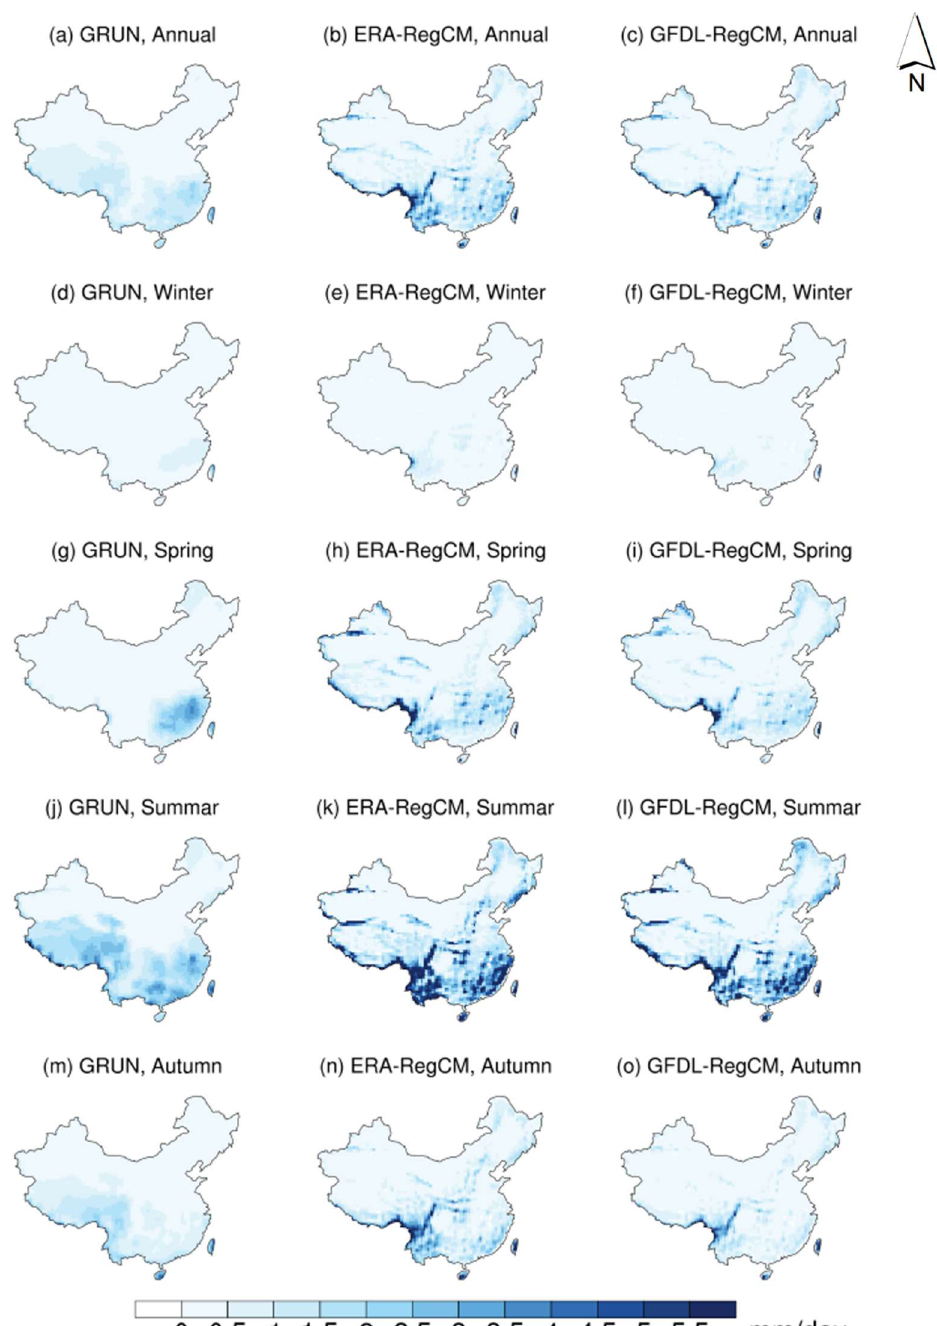
Figure 4. Reconstructed and RegCM-simulated runoff over China. The annual and seasonal averages are calculated with respect to the baseline period of 1986 to 2005.